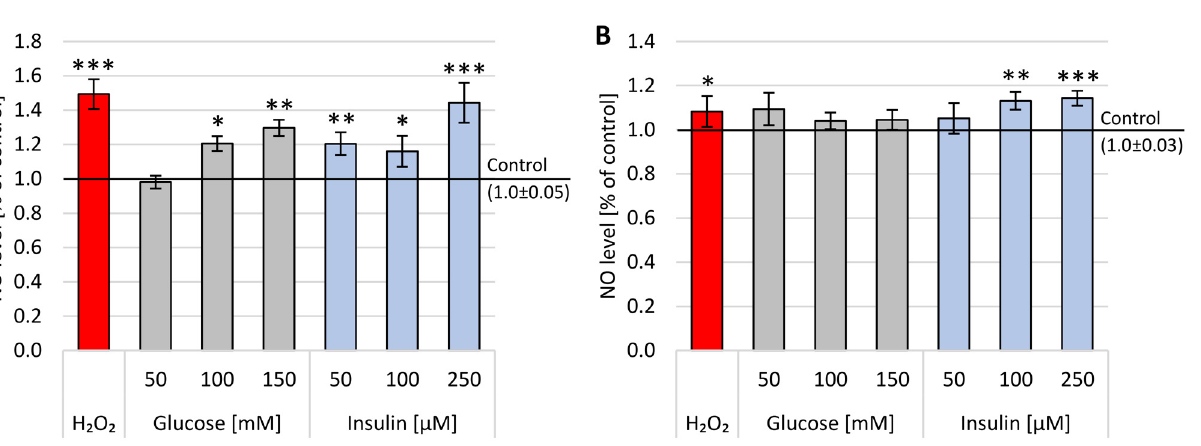
Figure 2. NO levels in neuron-like cells after: ( A ) 1 h incubation with glucose or insulin and ( B ) 24 h incubation with glucose (50, 100 or 250 mM) or insulin (50, 100 or 250 µM). Control—untreated neuron-like cells; H 2 O 2 —cells incubated with 50 µM H 2 O 2 (positive control). Statistically significant differences compared to the untreated neuron-like cells: * p < 0.05, ** p < 0.01, *** p < 0.001.